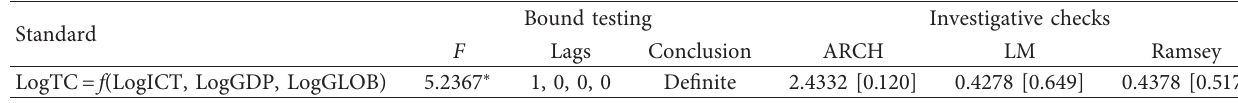
Table 3: Analysis for bound.